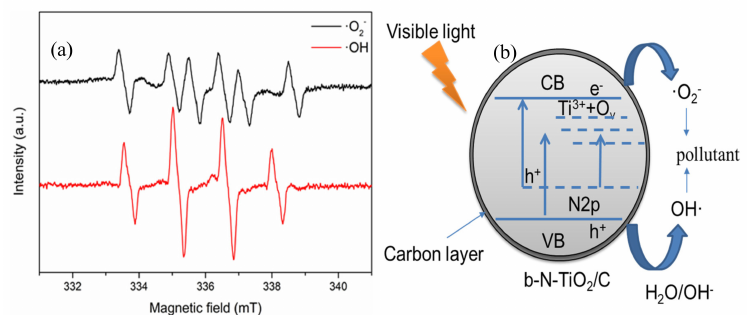
Figure 6. ( a ) ESR spectra of radical adducts trapped by 5,5-dimethyl-1-pyrroline N-oxide (DMPO) in 0.6N dispersion under visible light irradiation for 5 min; ( b ) Schematic illustration of the proposed mechanism for the degradation of pollutants by b -N-TiO 2 / C under visible light